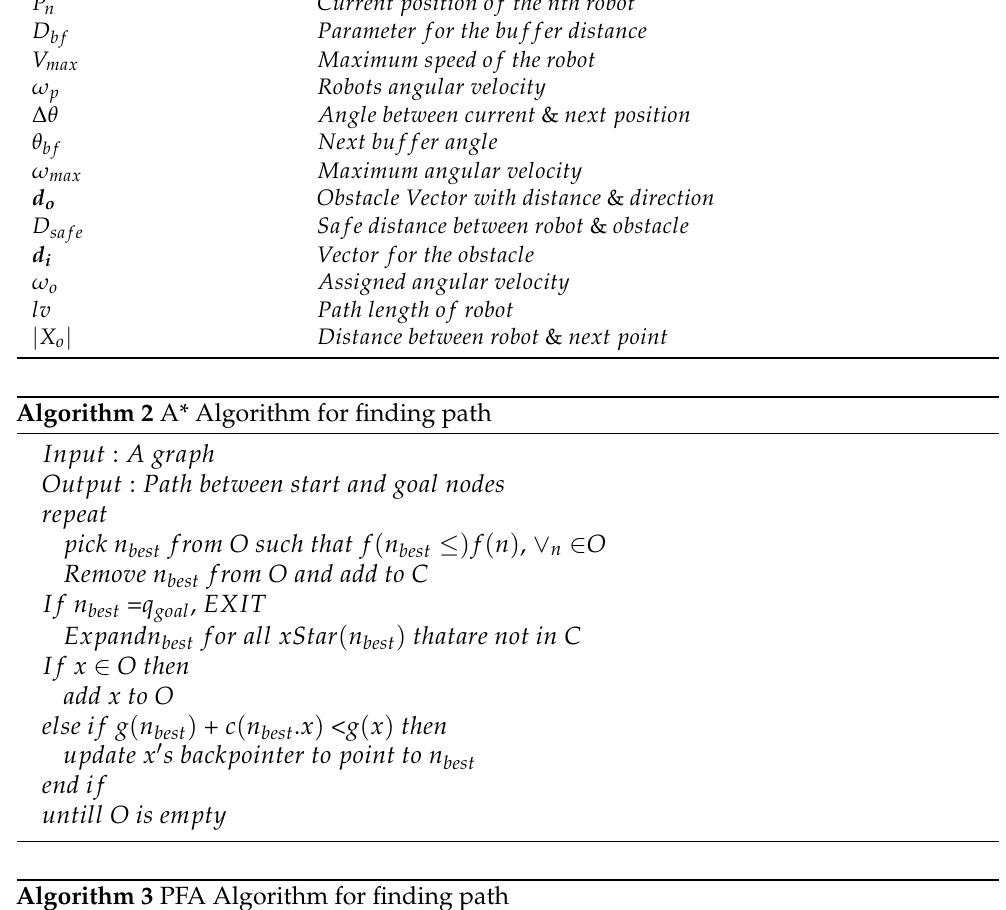
Algorithm 3 PFA Algorithm for finding